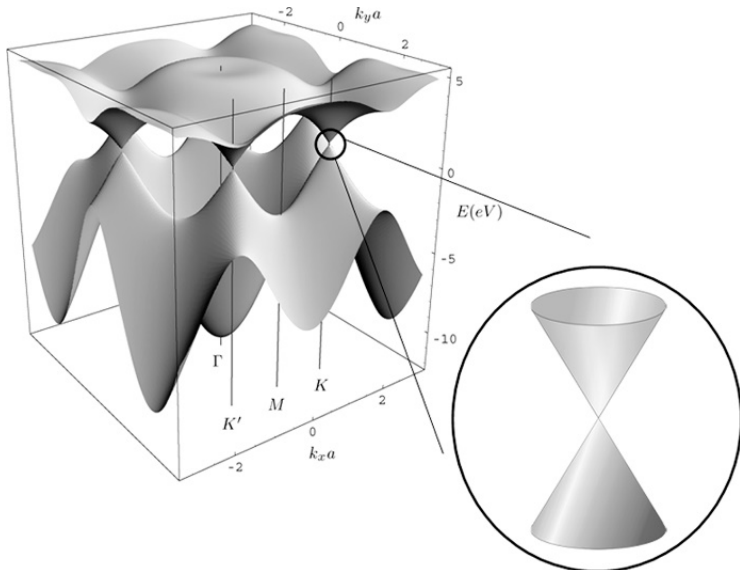
Figure 1. Schematic diagram for band structure of single-layer graphene. The inset on the lower right highlights the linear dispersion at the Dirac point. Reproduced from (Ernie W. Hill, [31]), Copyright 2011, IEEE.